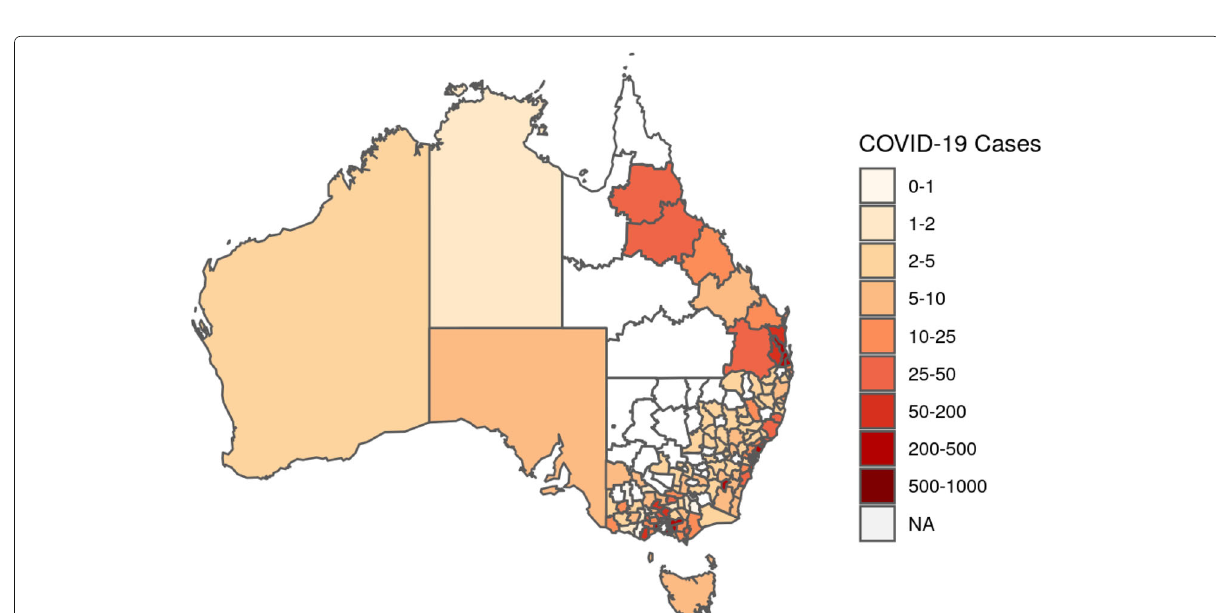
Fig. 2 Distribution of Total COVID-19 Cases at LGA Level Across